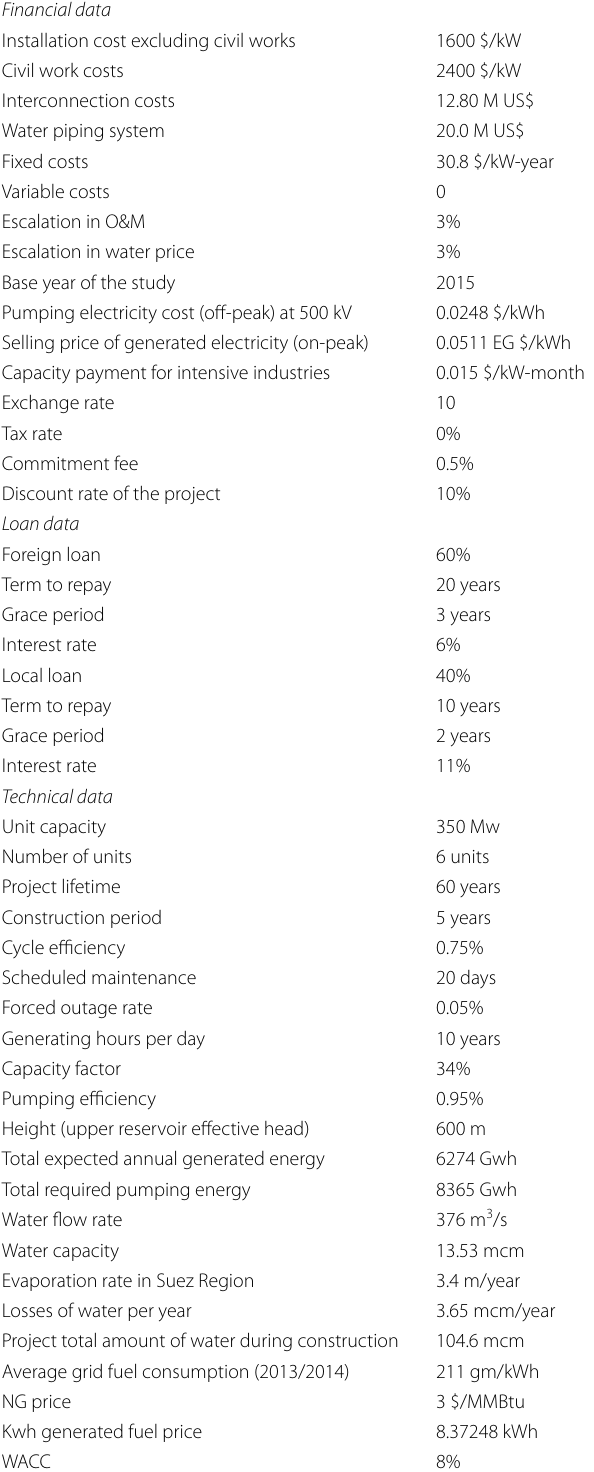
Table 1 Summary of assumptions of the